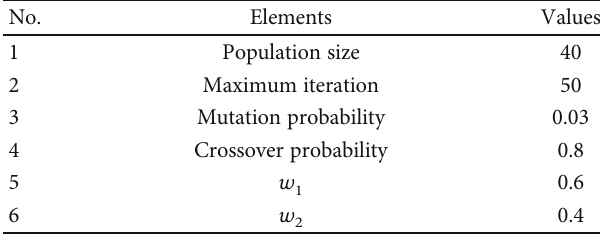
Table 1: GA algorithm input parameters.